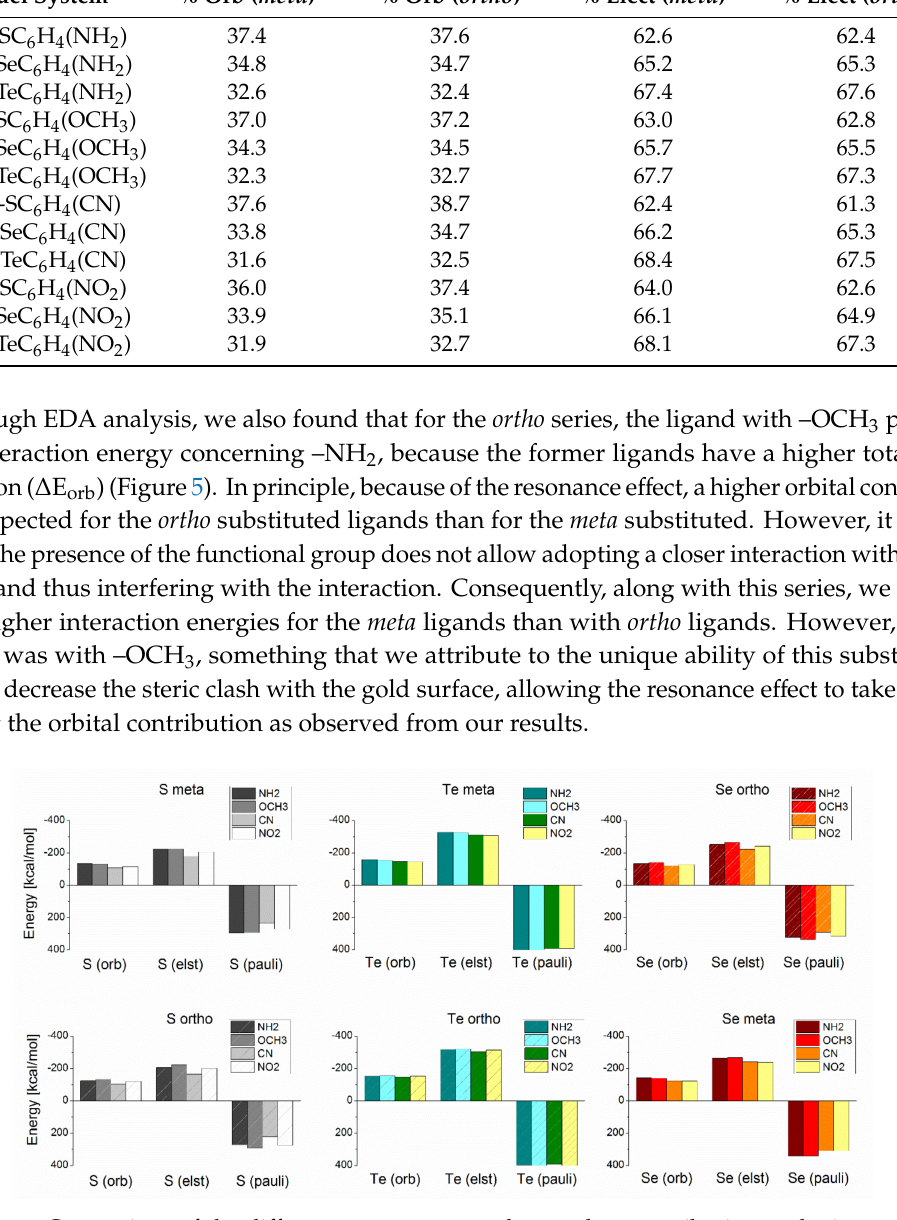
Figure 5. Comparison of the di ff erent components to the covalent contribution to the interaction energies obtained from the energy decomposition analysis of ortho and meta substituted ligands with –NH 2 , –OCH 3 , –CN, and –NO 2 as functional